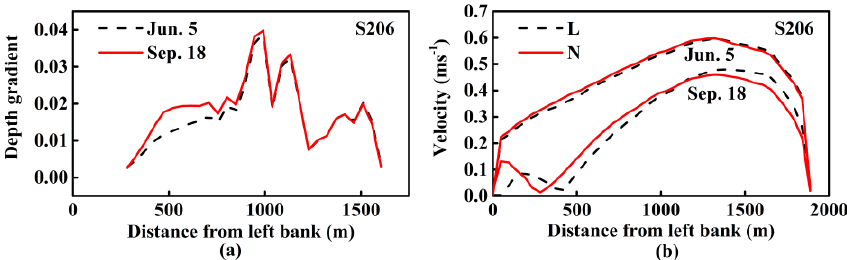
Figure 9. ( a ) Depth gradient (represents bed topography effects). ( b ) Velocity distribution predicted by the N and L models at S206 on typical days of the first and last period, respectively.